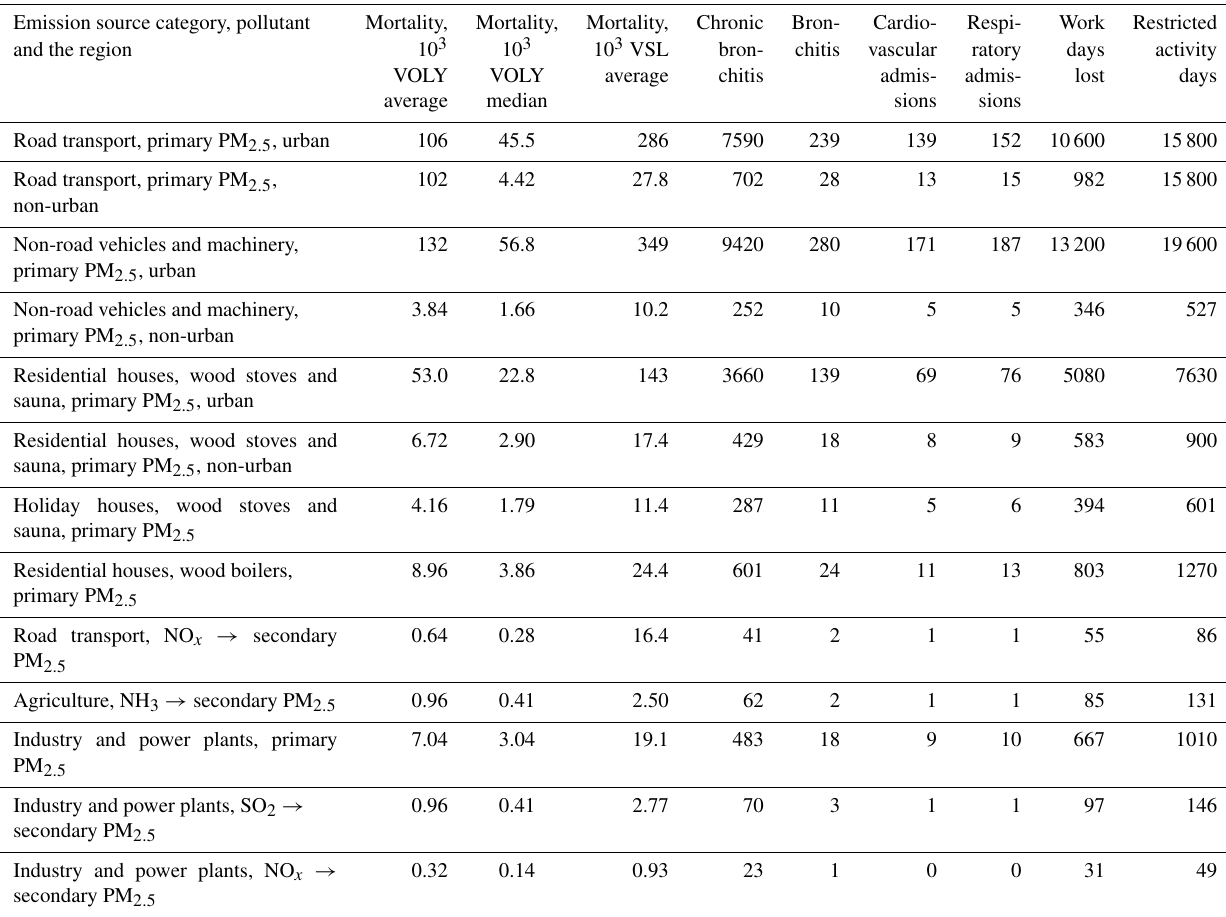
Table A1. Public health costs in thousands of EUR (for mortality) or EUR (for chronic bronchitis and bronchitis) for 1t of source-specific PM 2 . 5 emissions for various health outcomes in Finland in 2015, and the numbers of hospital admissions, work days lost and restricted activity days. Note: VOLY – value of life year; VSL – value of statistical life. The values have been presented using three significant